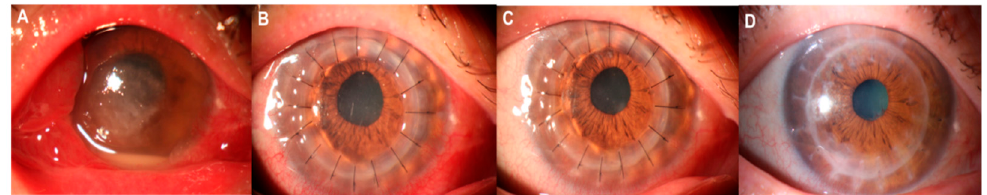
Figure 4. Anterior segment photographs of a UZS patient during the 15-month follow-up period: ( A ) preoperatively; ( B ) fourteen days postoperatively; ( C ) one and half months postoperatively; ( D ) one year and three months postoperatively.